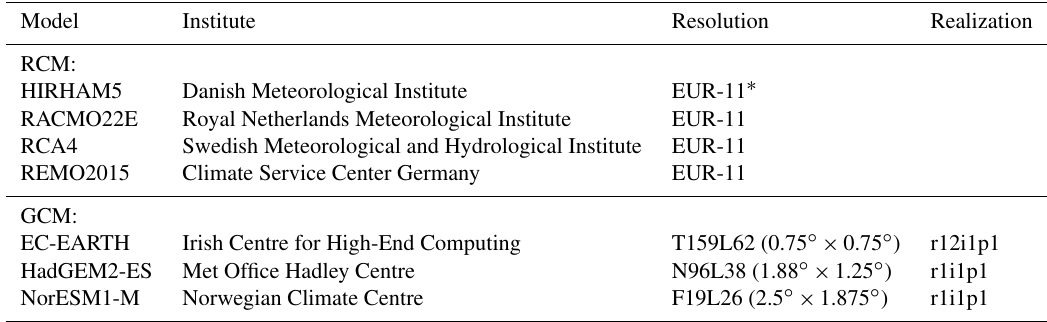
Table 1. The RCMs and the driving GCMs that form the simulation matrix in the study. Model